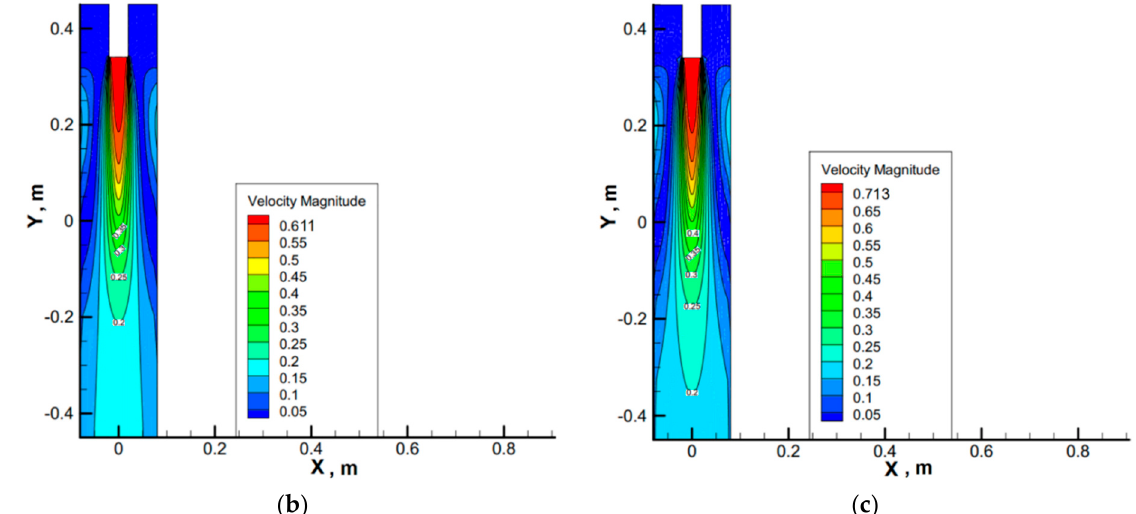
Figure 12. Cell division of computational domain ( a ) and the calculated velocity distribution of billet No. 1 ( b ) and No. 2 ( c ). The velocity that the molten steel flows into the mold can be obtained by the casting speed and the throughput of molten steel.